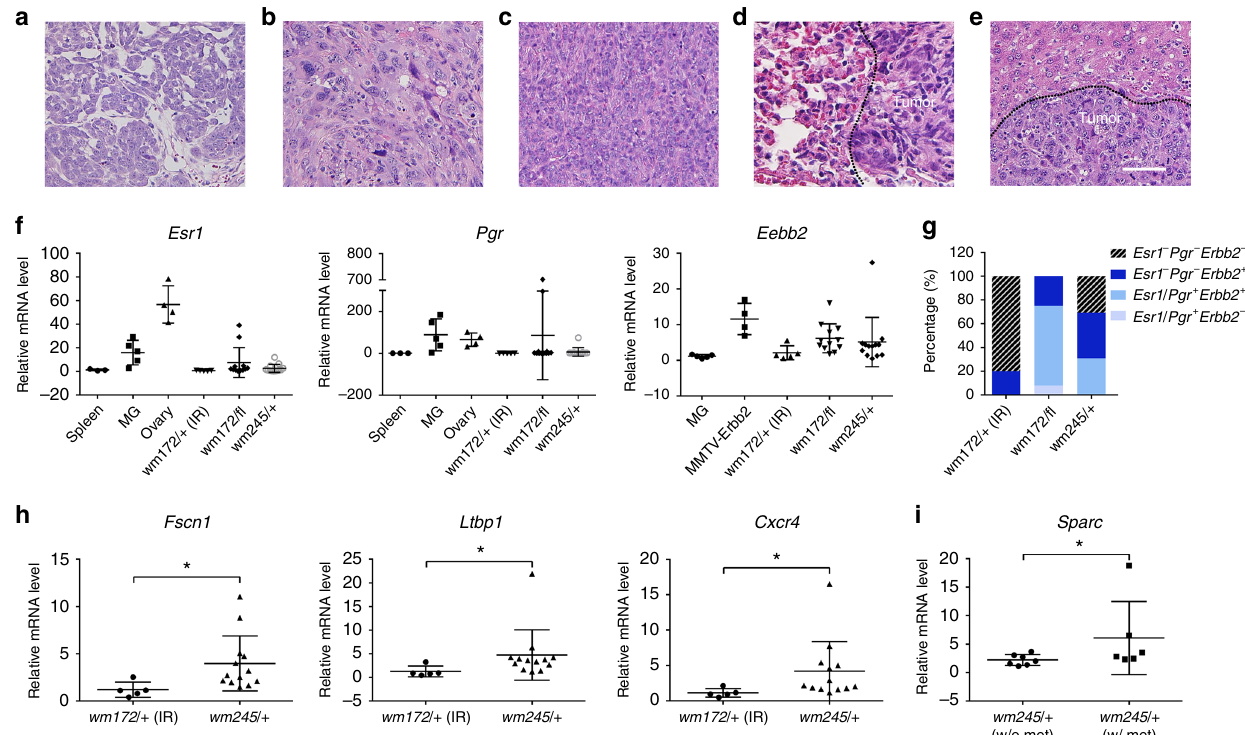
Fig. 3 Characteristics of the p53R172H and p53R245W mammary tumors a – e Hematox;ylin and Eosin-stained sections of mammary tumors from mice showing different pathological subtypes. a A moderately-differentiated adenocarcinoma. Note glandular and nesting formation of tumor composition; b A highly anaplastic cellular manifestation including spindle cell, cellular pleomorphism and loss of glandular and differentiation features; c A sarcomatoid carcinoma with an undifferentiated sarcoma-like manifestation. d A localized metastatic adenocarcinoma in lung. Tumor nodule displays glandular proliferation of well-to-moderately-differentiated adenocarcinoma of mammary origin; e A metastatic tumor to liver. The tumor displays the same phenotypic anaplasia seen in primary tumor ( b ). Note the distinct boundary of metastases and normal tissues, as marked by the dashed line. Scale bar is 50 μ m and applies to all sections. f RT-qPCR analysis for Esr1 , Pgr and Erbb2 in WT mouse spleens, mammary glands (MG), or ovaries, or mammary tumors from the MMTV-Erbb2 mice, and tumors from Ad-Cre-injected mice of various Trp53 genotypes ( wm172/ + , wm-R172H/ + ; wm172/ fl , wm-R172H/ fl ; wm245/ + , wm-R245W/ + ). IR, γ -radiation. Error bars, s.d. g Summary of the molecular subtypes of mammary tumors from mice of various genotypes, based on data in f. Esr1/Pgr + label means Esr1 postive or Pgr positive, or both. h RT-qPCR analysis for Fscn1 , Ltbp1, and Cxcr4 , in Trp53R245W-driven mammary tumors compared to Trp53R172H mammary tumors. Error bars, s.d. * p < 0.05 ( t -test) i RT-qPCR analysis for Sparc in